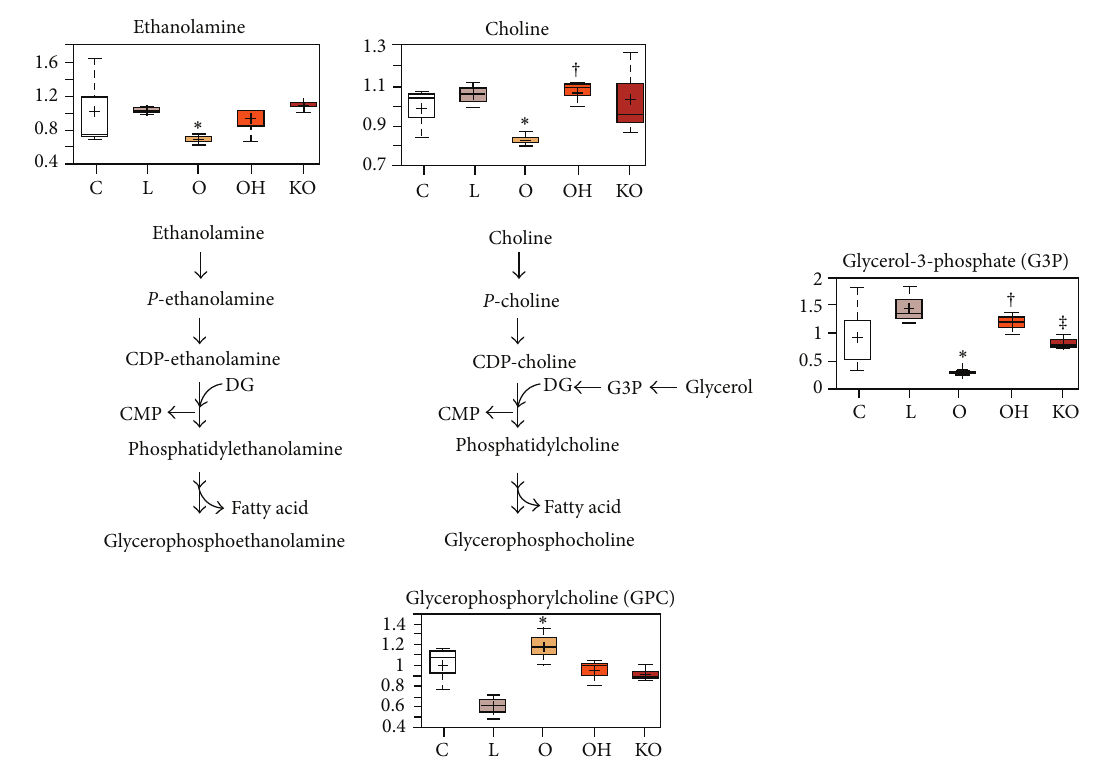
Figure 4: Variations in phospholipid metabolites in HUVEC cell homogenates ( 𝑛 = 3 , for each experiment). Endothelial cells were incubated over24 hwith50 mg/LisolatedhumanLDL(L);50 mg/LoxidizedLDL(O);50 mg/LoxidizedLDL+40 mg/LHDLfromwildtypemice(OH); 50 mg/L oxidized LDL + 40 mg/L HDL from PON1 (−/−) mice (KO); or with serum-free media as controls (C). ∗ 𝑃 < 0.05 with respect to L; † 𝑃 < 0.05 with respect to O; ‡ 𝑃 < 0.05 with respect to OH.